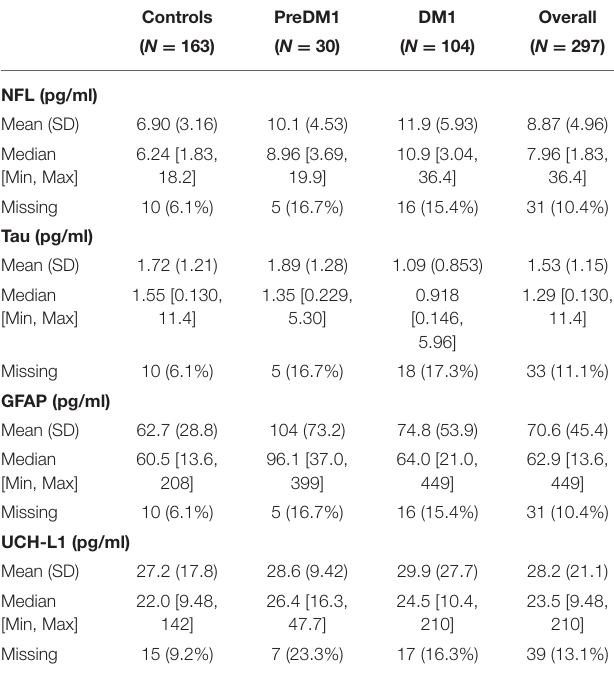
TABLE 3 | Descriptive statistics of blood-based markers of brain injury.